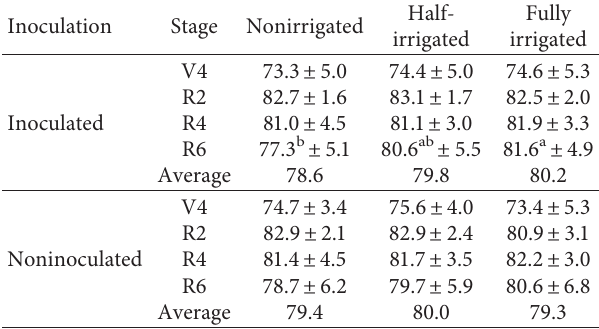
Table 6: The effect of different irrigation regimes on NDVI at different stages of soybean’s (cv. Bogl´ar) life cycle, averaged among 2017, 2018, and 2019 in Debrecen,